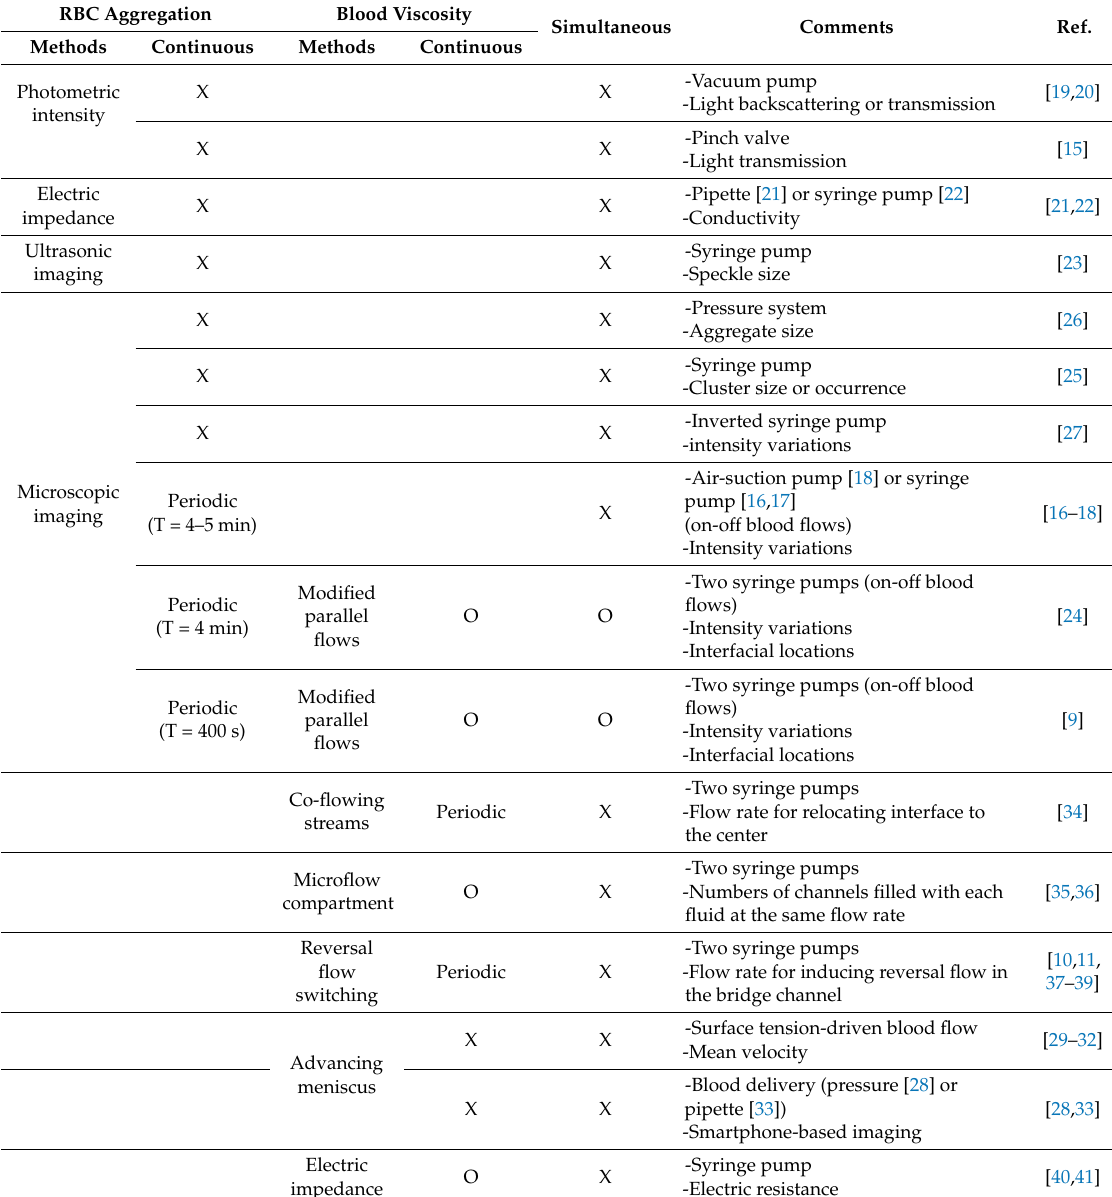
Table 1. Summary of microfluidic-based technique for measuring red blood cell (RBC) aggregation and blood viscosity (O and X denote possible method and impossible method,